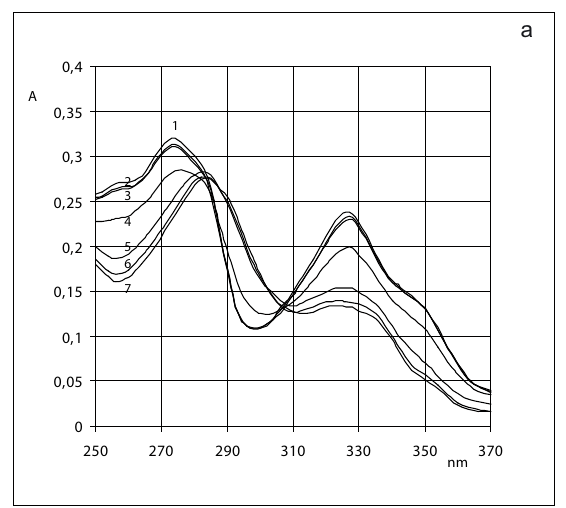
Figure 2. Absorption spectra of sanguinarine (a) in 100 mmol L -1 HCl and dihydrosanguinarine (b) in 60% (v/v) methanol and